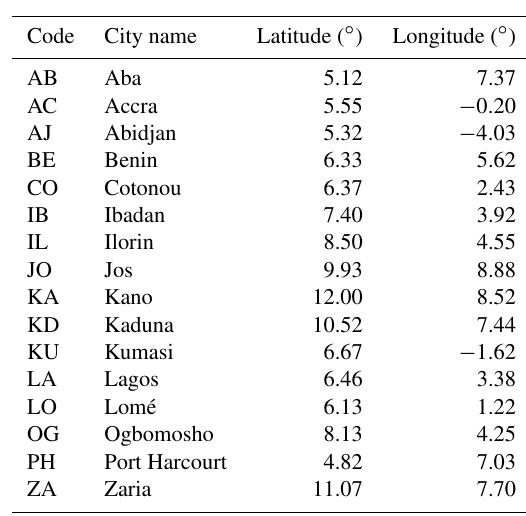
Table 1. List of cities in Fig.